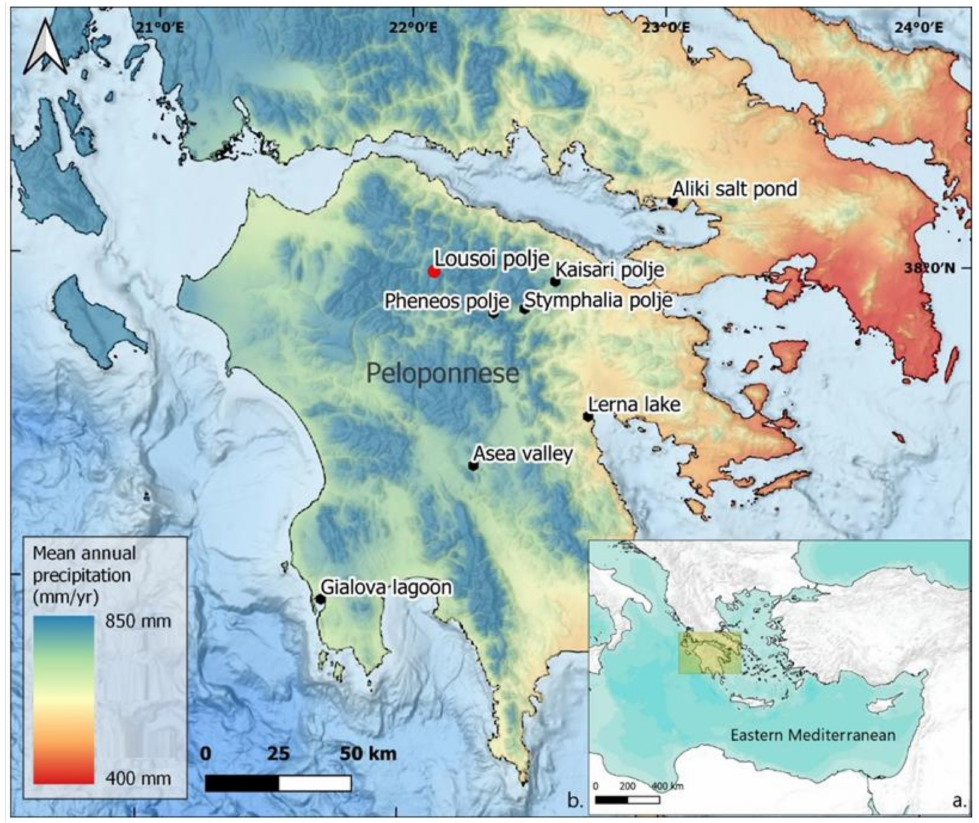
Figure 1. ( a ) Eastern Mediterranean map with the study area highlighted in yellow box; ( b ) map of Peloponnese, displaying the archives discussed in this study along with the mean annual precipitation of the region for the period 1970–2000